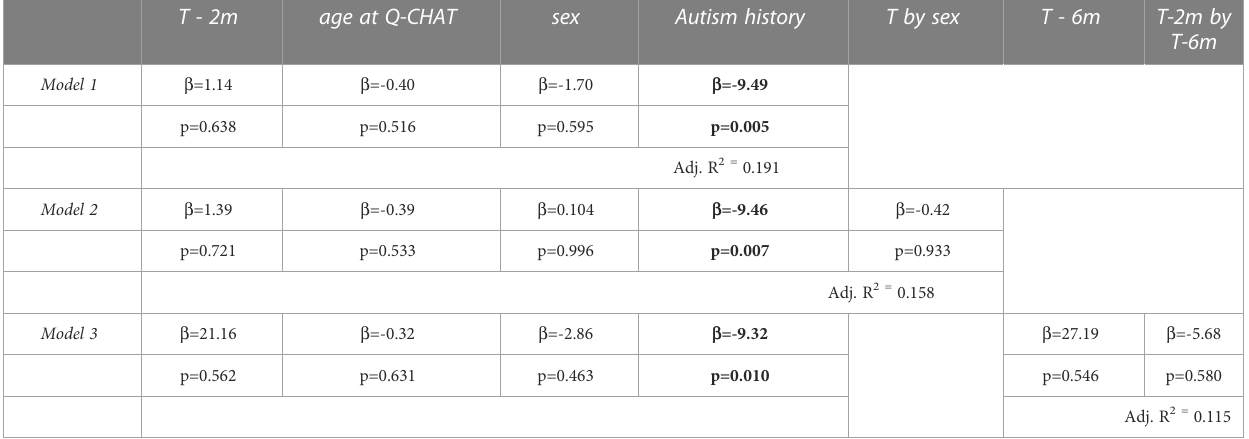
TABLE 1 Multiple regression models of log-transformed testosterone levels (T) to autistic traits (Q-CHAT scores). T - 2m age at Q-CHAT